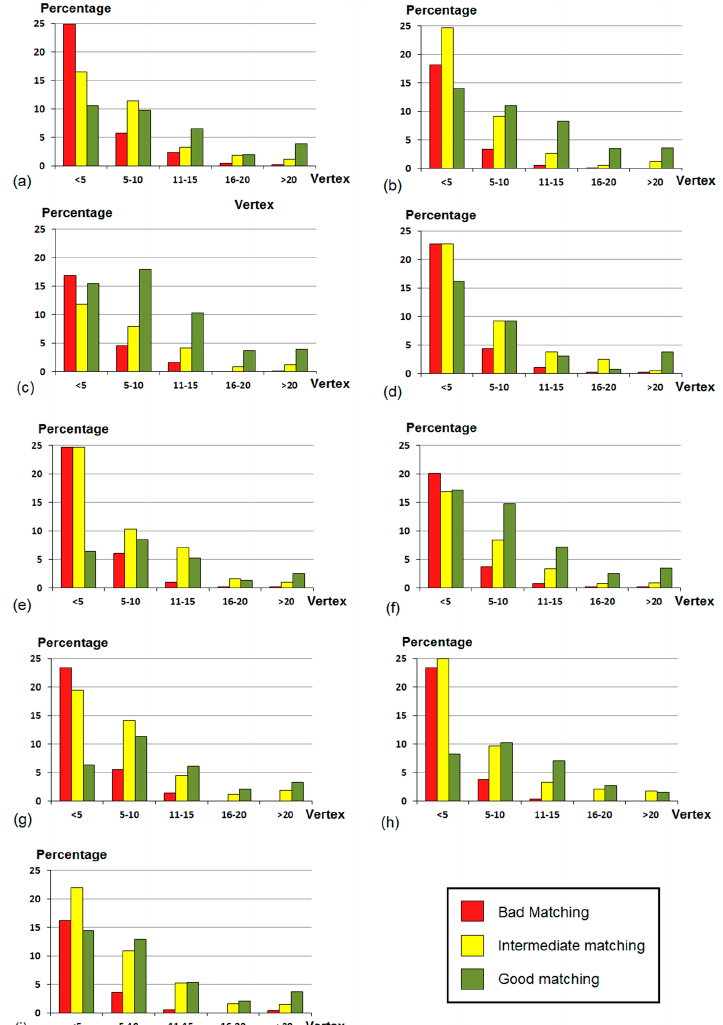
Figure 8. Percentage distribution of matched polygons for each interval of accuracy (MAV) grouped by number of vertexes of the BTN25 for each urban area under analysis: ( a ) Mairena del Alcor, ( b ) Alcalá de Guadaira, ( c ) Carmona, ( d ) F. Vaqueros, ( e ) Santa Fe, ( f ) Granada, ( g ) Coín, ( h ) Alhaurín de la Torre, ( i ) Fuengirola